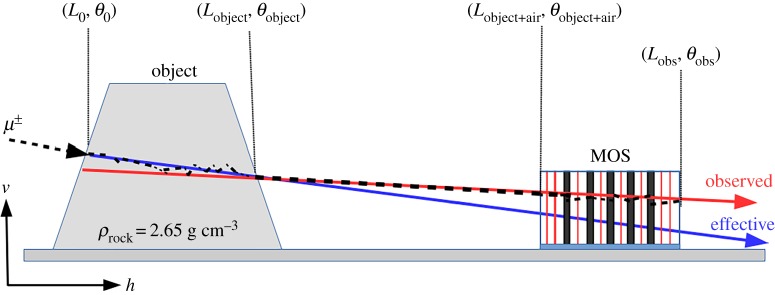
The schematic drawing of land-based muography. The multiple scattering of a muon across the object causes that its observed trajectory (red arrow) differs from the effective one (blue arrow) which carries information about the amount of material along the path of muon across the object. (Online version in colour.)